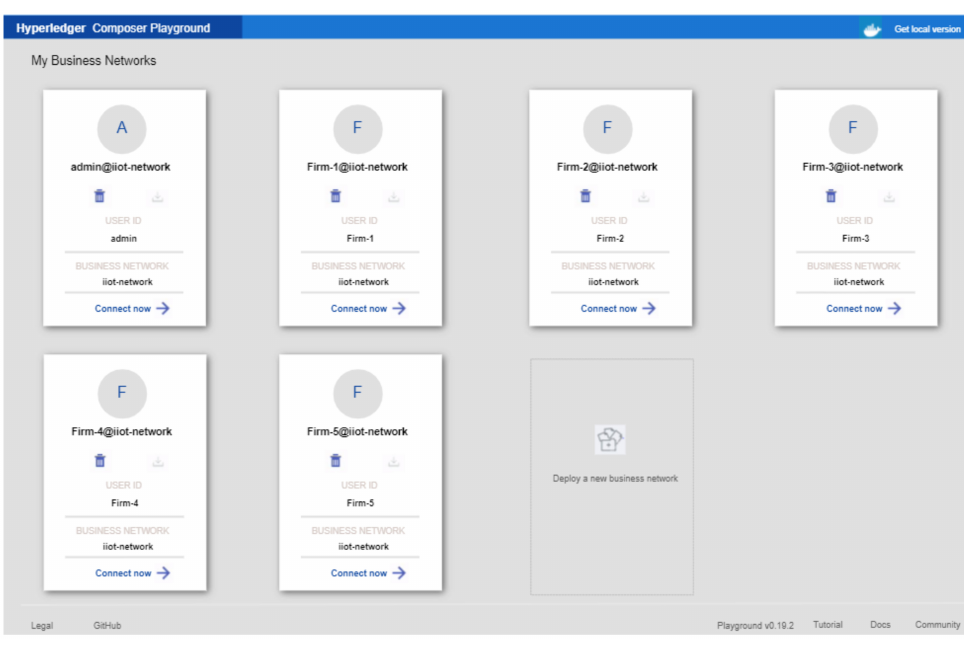
Figure 16. Login interface.